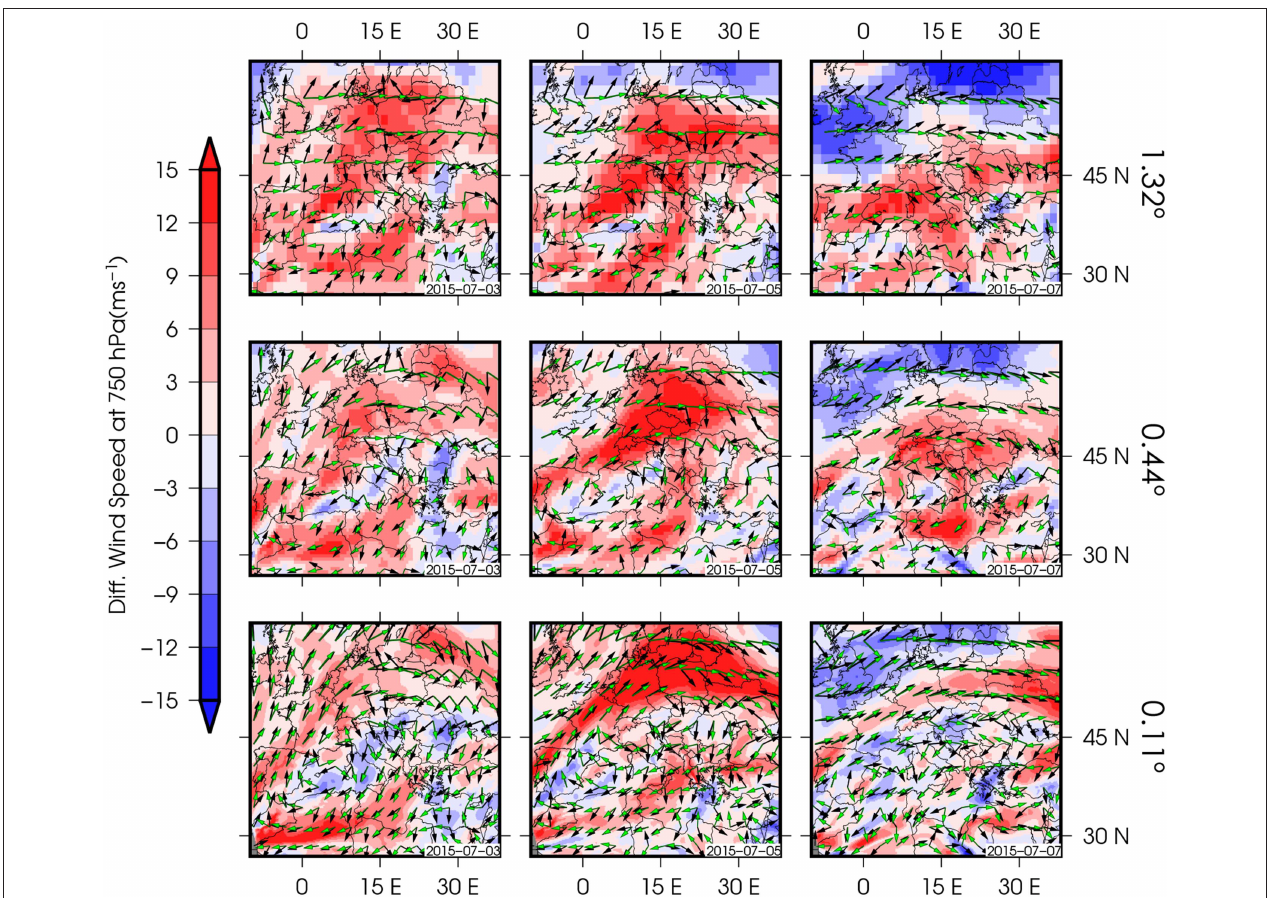
FIGURE 5 | Daily wind speed differences between ERA5 and simulations at different resolutions at 1.32 ◦ (first row), at 0.44 ◦ (second row); and at 0.11 ◦ (third row) during 3rd, 5th, and 7th of July (left, center, and right, respectively). Wind speed bias is depicted in colors and arrows represent the wind direction from ERA5 (black) and modeled